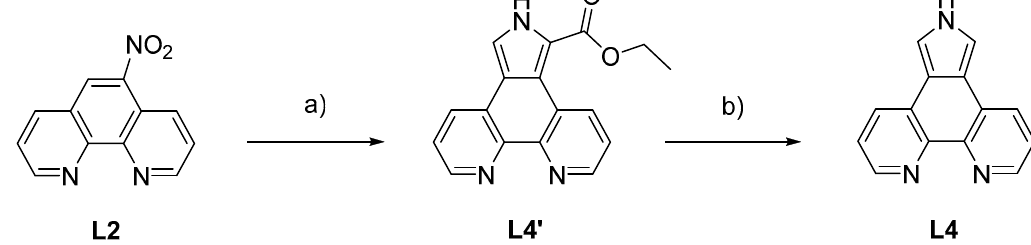
Figure 2. Phenanthroline-based ligands L2 – L4 .